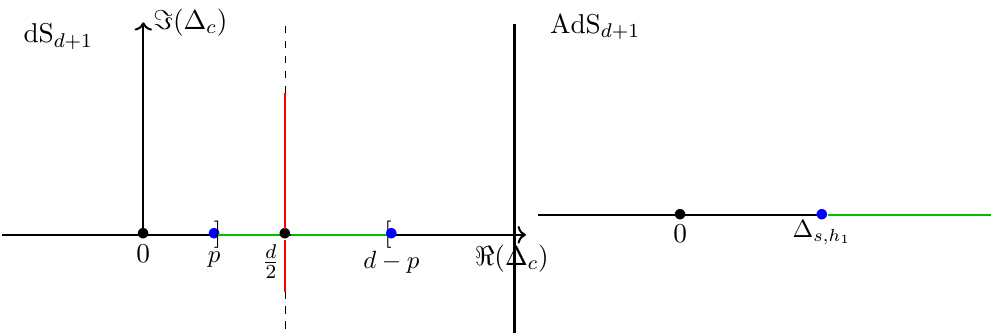
Figure 3 . Repartition of massive and massless (cid:12)elds in dS d +1 (left) and AdS d +1 (right) as a function of the conformal weight (cid:1) c = (cid:1), for a (cid:12)xed diagram Y of total height p (cid:0) 1, and (cid:12)rst block of height h 1 and length s . On the left / de Sitter side, massive (cid:12)eld in the principal and complementary series are depicted respectively by a red and a green line, the massless (cid:12)eld is represented by a blue dot. On the right / anti-de Sitter side, massive (cid:12)elds correspond to the green line and the massless (cid:12)elds are the blue